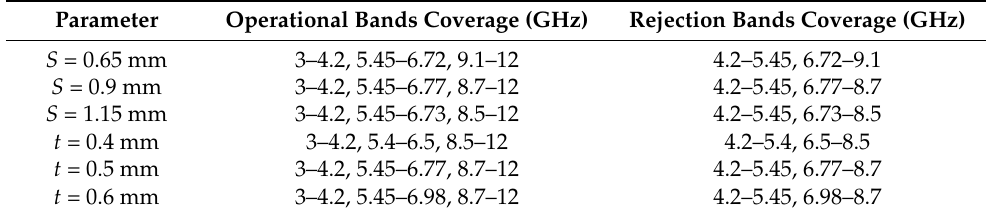
Table 3. Operational and Rejection band coverage by varying parameters ‘ S ’ and ‘ t ’.